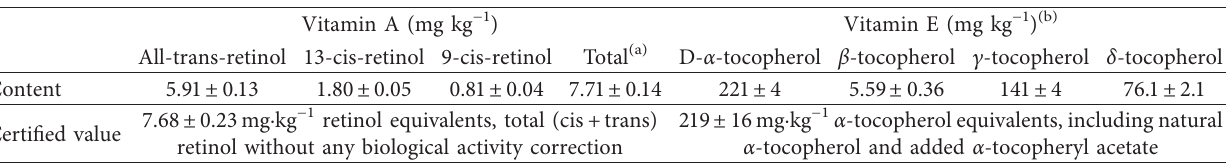
Table 3: Retinol and vitamin E isomer contents in certified reference materials (SRM